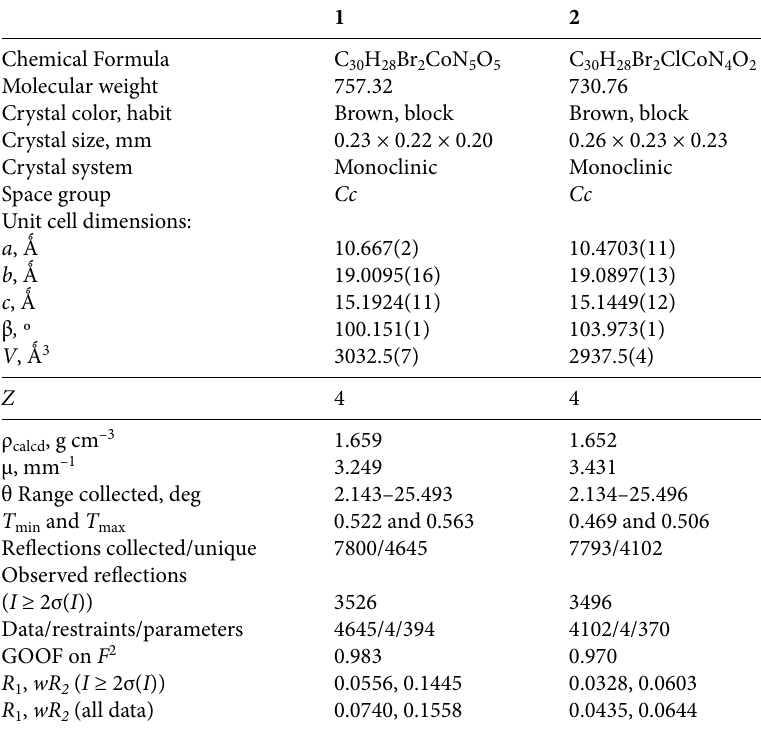
Table 1. Crystallographic data and refinement details for the